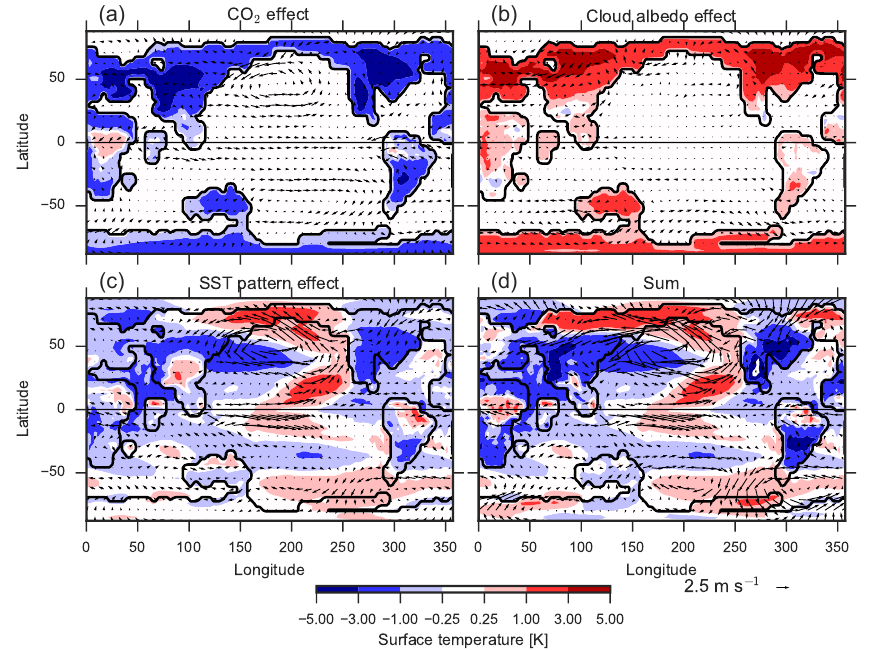
Figure 5. Change in annual-mean surface temperature (shading) and 900hPa wind (arrows) between the GHG run and the fixed-SST simulation with (a) reduced CO 2 , (b) reduced cloud albedo and (c) change is SST pattern, as well as (d) the sum of all